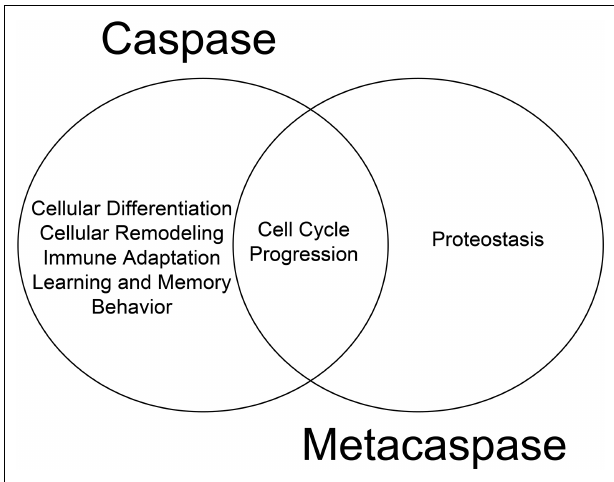
FIGURE 1 | Functional overlap of caspase and metacaspase function. Regulation of cell cycle progression is a conserved function for both proteases, suggesting a common evolutionary origin. Additional non-death functions of metacaspases such as the role ofYca1 in proteostasis has yet to be confirmed as a feature of caspase